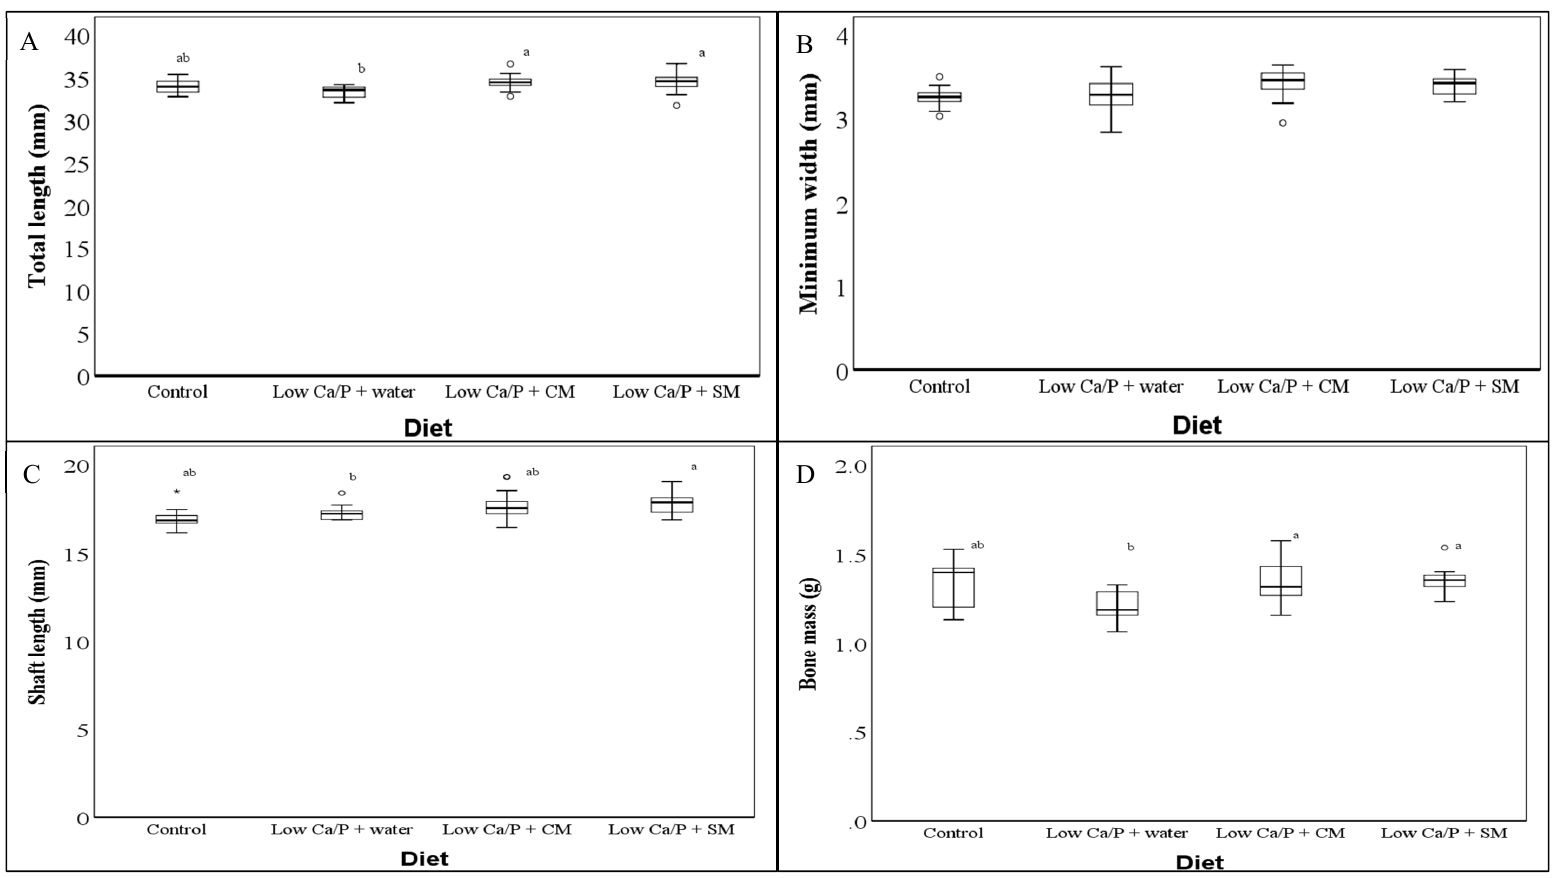
Figure 1. ( A–D ): Macroscopic dimensions of the femora of rats fed different diets ° and * Indicate outliers as identified by SPSS 24. Significant differences in bone parameters between the different diets are indicated by superscript letters as determined by the Kruskal–Wallis test and Dunn’s test with Bonferroni correction ( p < 0.05).